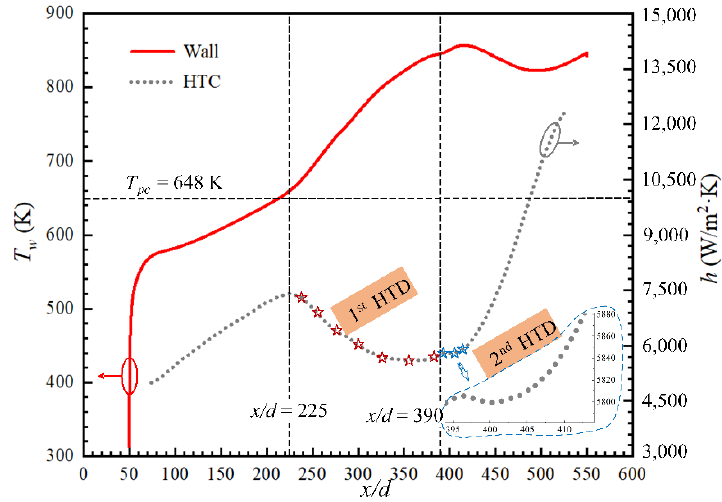
Figure 5. Variations in the wall temperature and HTC along the flow direction.